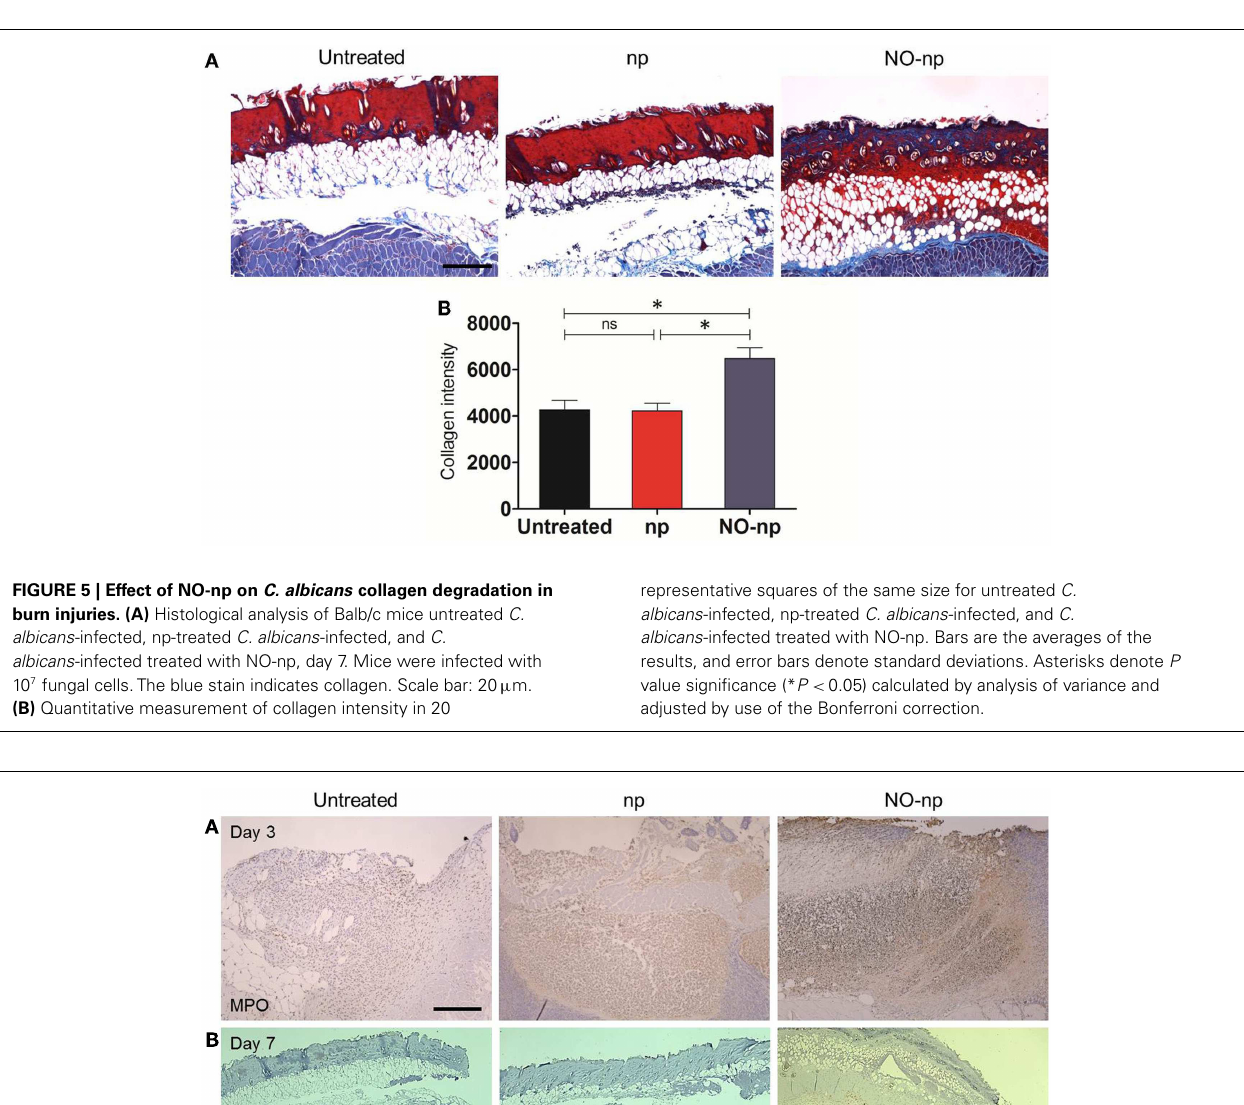
FIGURE 6 | Influence of NO-np on neutrophil and macrophage-like cell infiltration into burn wounds. (A) Histological analysis of untreated, np-treated and NO-np-treated wounded Balb/c mice, day 3. The brown staining indicates neutrophil infiltration. Representative MPO-immunostained sections of the skin lesions are shown. Scale